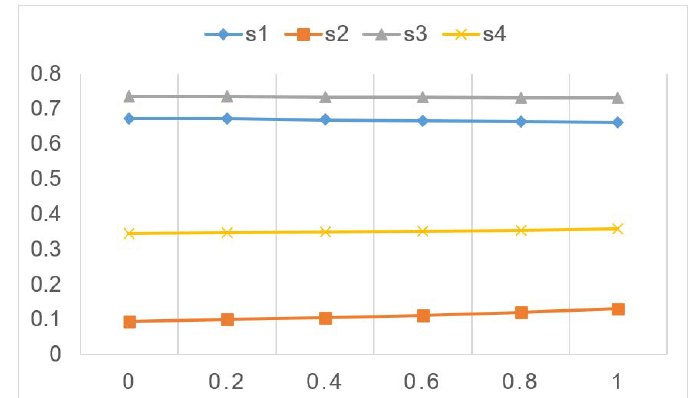
Fig. 1 The influence of β on the order of the